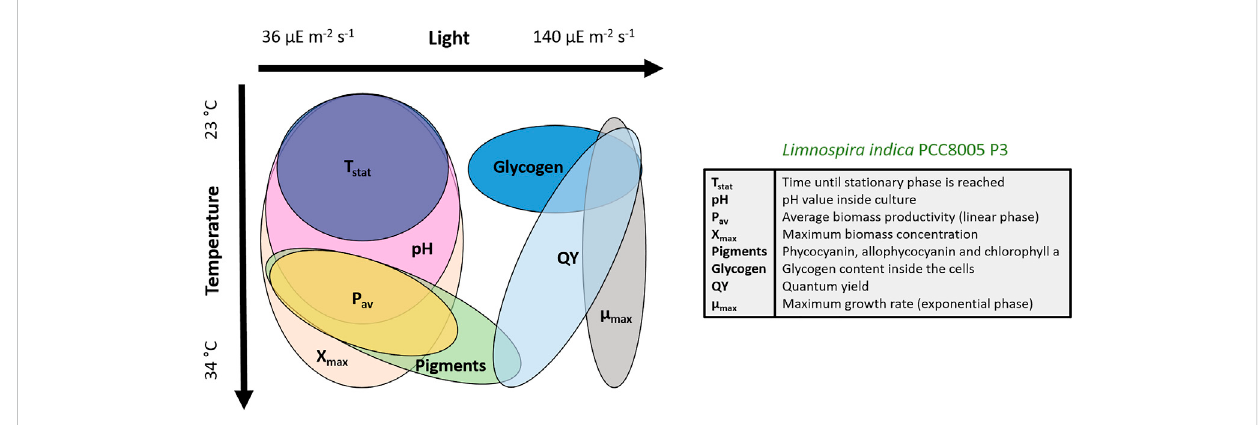
FIGURE 6 Qualitative overview of the impact of light and temperature on Limnospira indica PCC8005 P3. The maxima of each parameter are